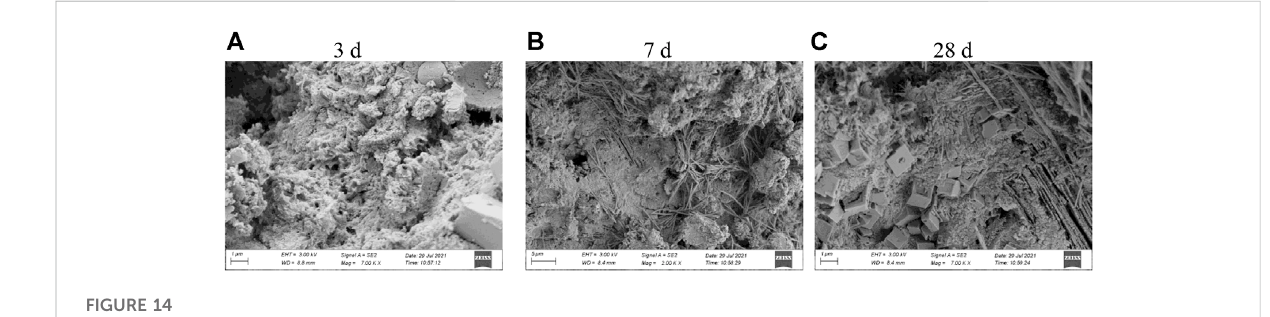
FIGURE 14 SEM images of the net slurry